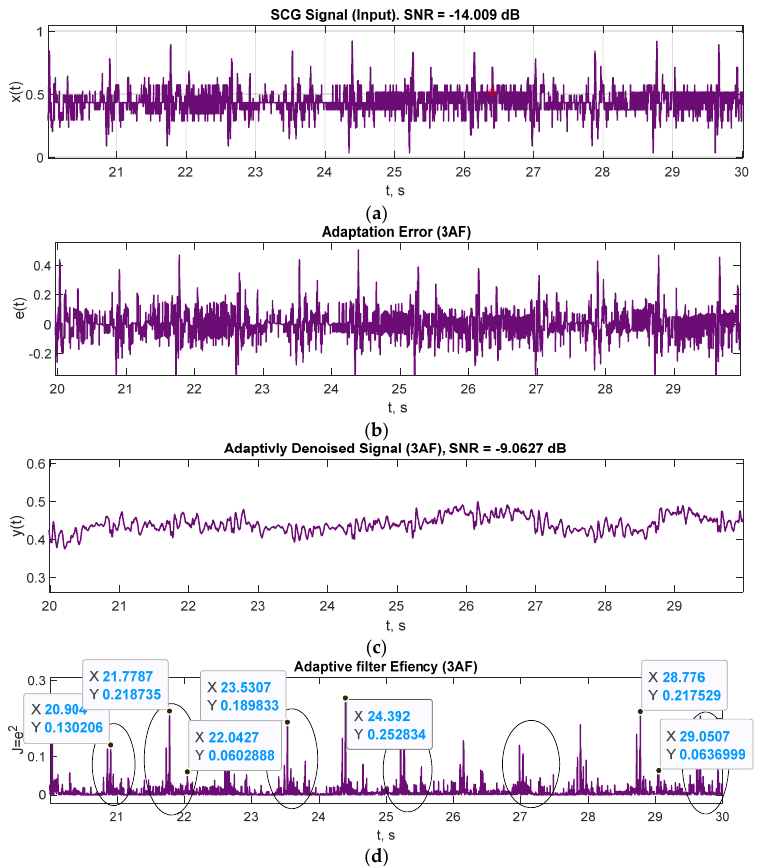
Figure 8. Processing seismocardiogram signal in the first adaptive filter with sample delay 5 and the FIR filter in the input. ( a ) SCG signal on input. ( b ) Adaptation error of the first adaptive filter. ( c ) Adaptively filtered signal. ( d ) The efficiency of the filter.